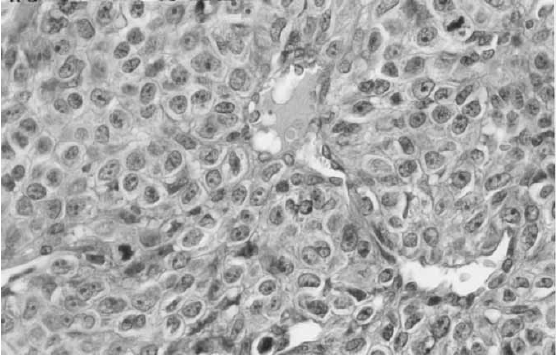
Fig. 3. A prominent vascular component is always present with features sometimes reminiscent of hemangiopericytoma (H&E, (cid:1) 4).